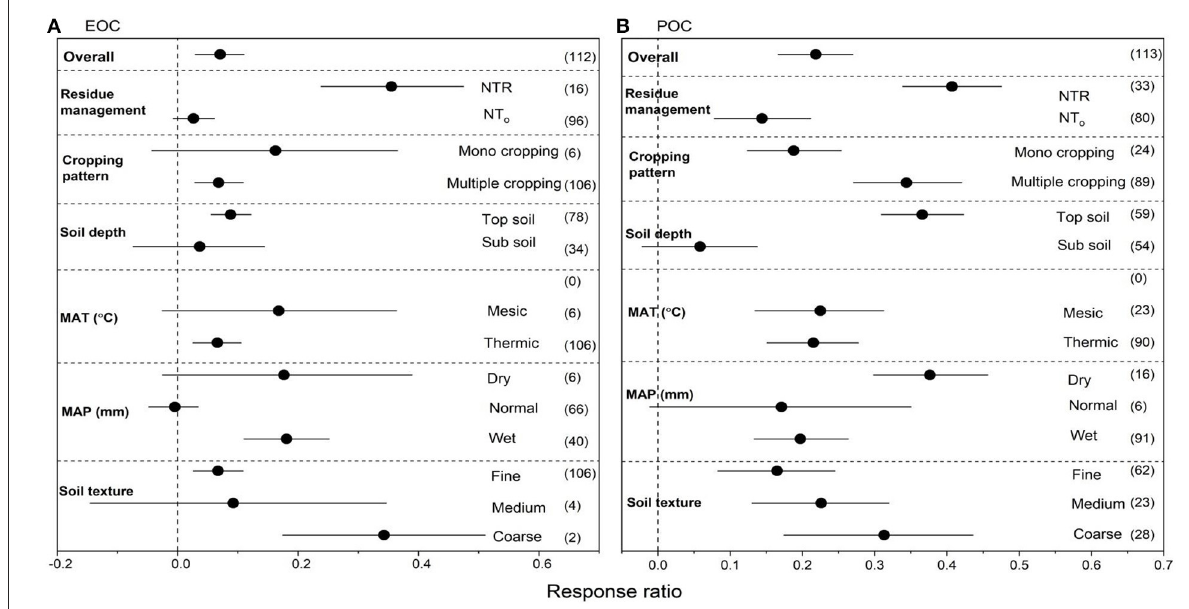
FIGURE4 (A,B) The effect size of easily oxidized organic carbon (EOC) and particulate organic matter (POC) with NT compared to CT. If 95% confidence intervals (CIs) do not overlap with zero, there is a substantial difference in the effect size between treatments. Error bars display CIs. The sample size for each variable is displayed next to each bar. The acronyms stand for mean annual temperature (MAT), mean annual precipitation (MAP), retention of residue (NTR), and no residue retention